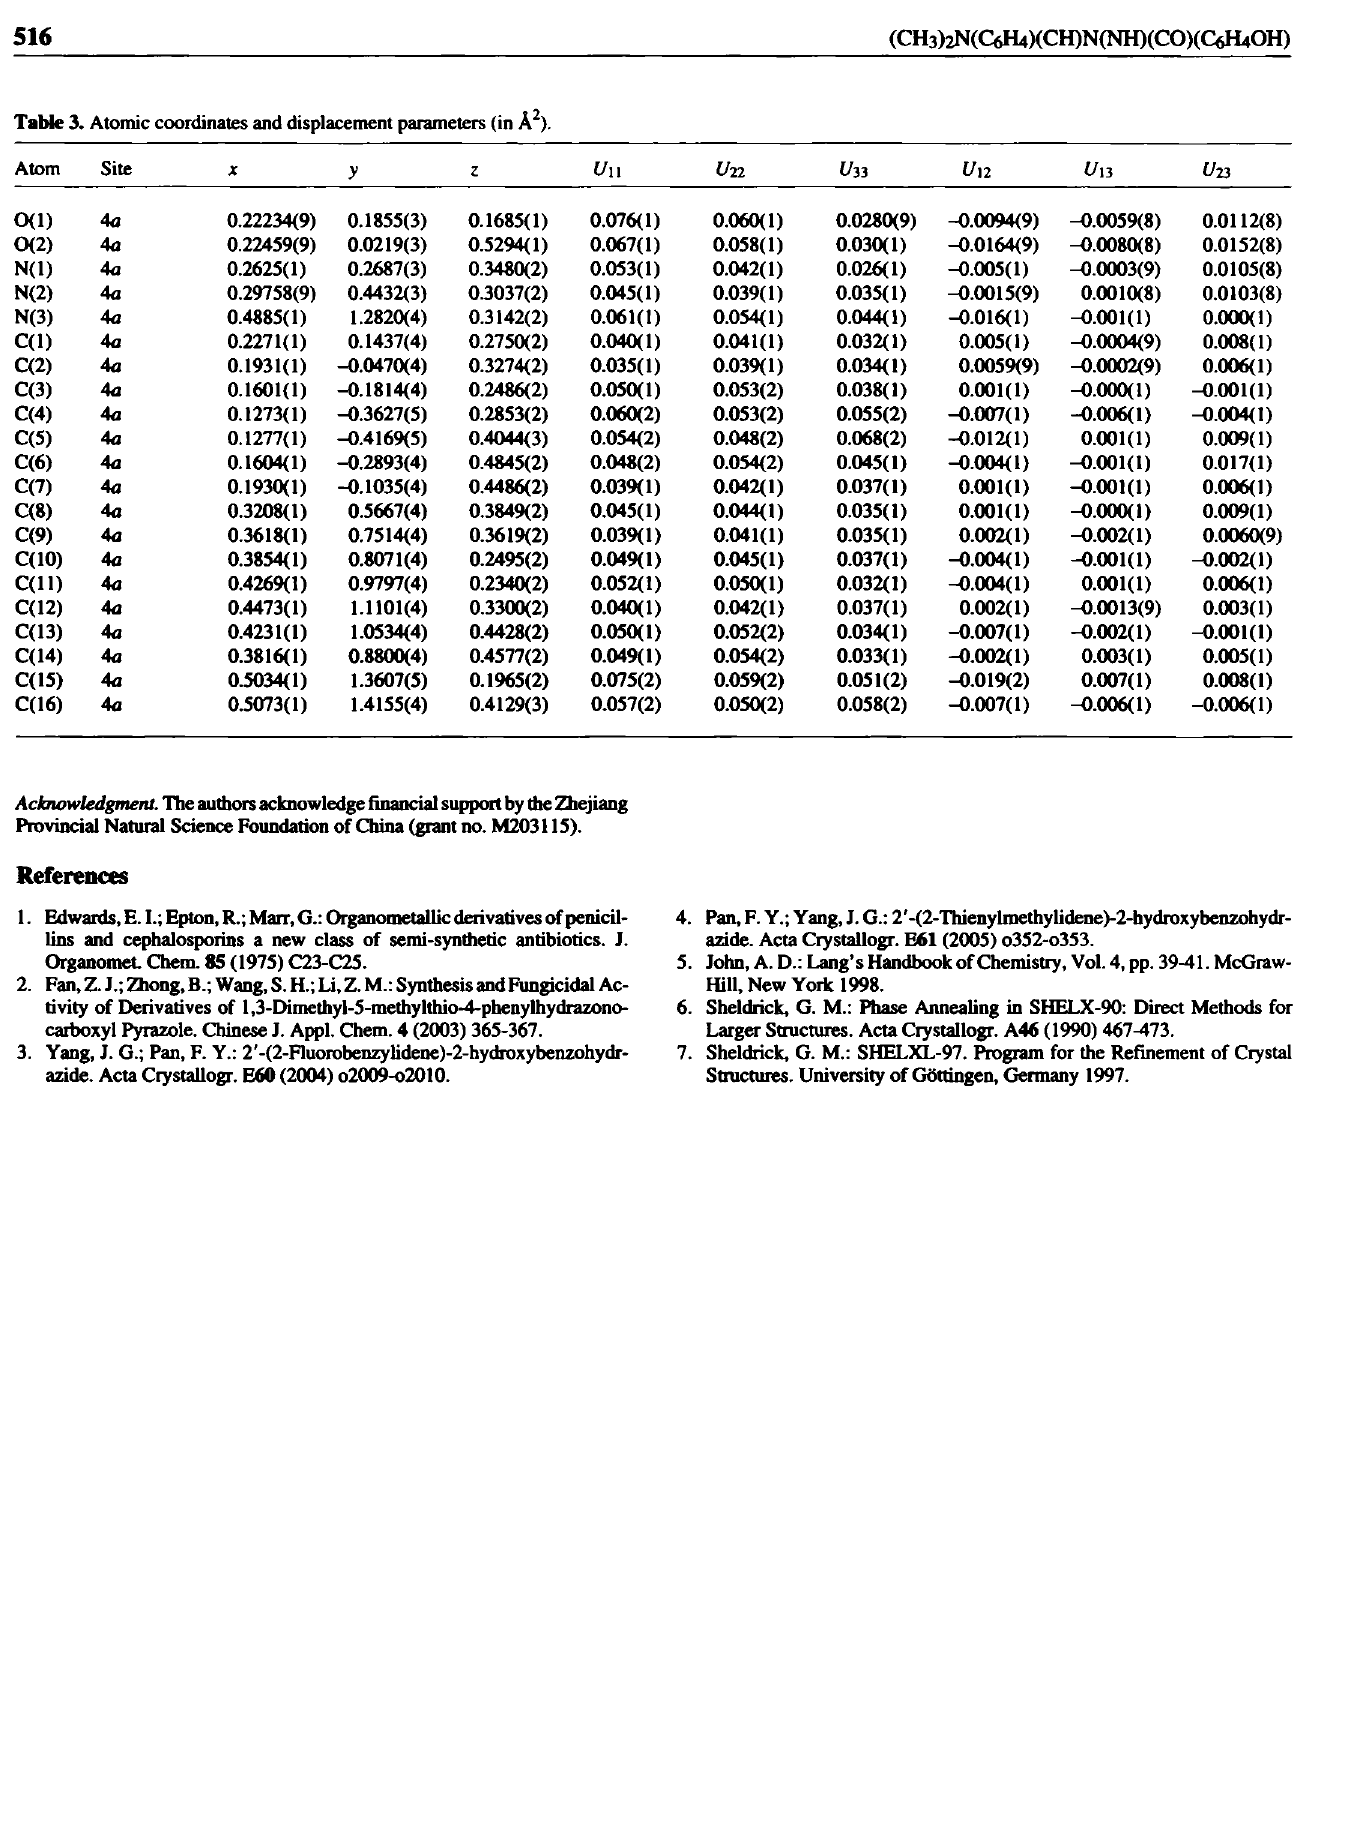
Table 3. Atomic coordinates and displacement parameters (in Ä 2